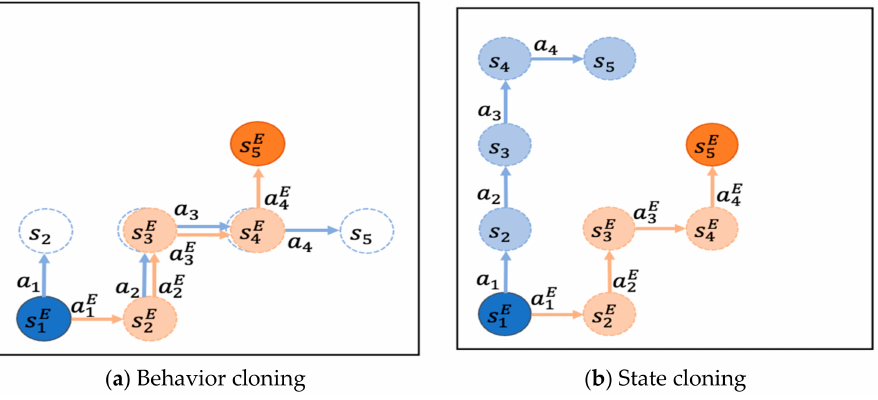
Figure 1. Behavior cloning (BC) vs. state cloning